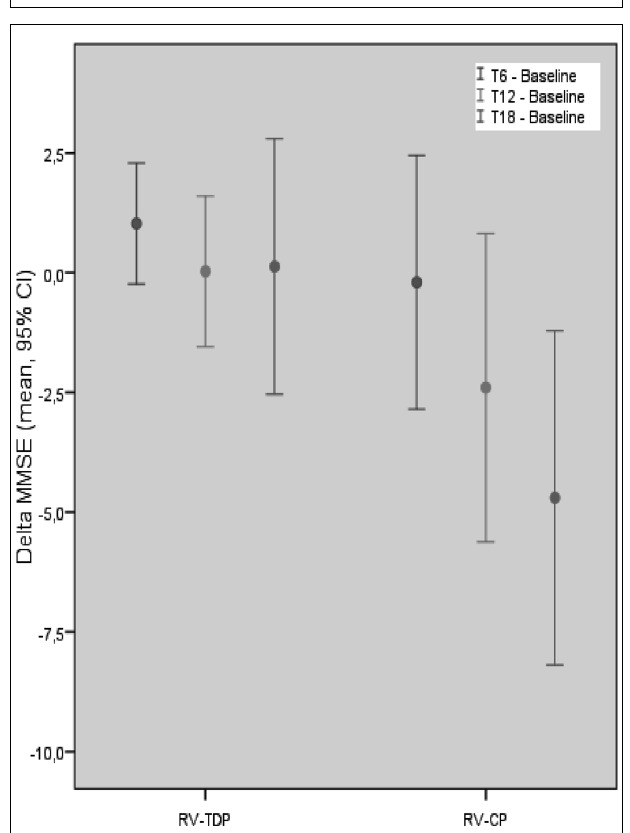
FIGURE 2 | Mean of the MMSE score difference between follow-up at T18,T12,T6, and baseline in each group with MMSE baseline score covariation (RV-TDP, rivastigmine transdermal patch; RV-CP, rivastgmine capsules).